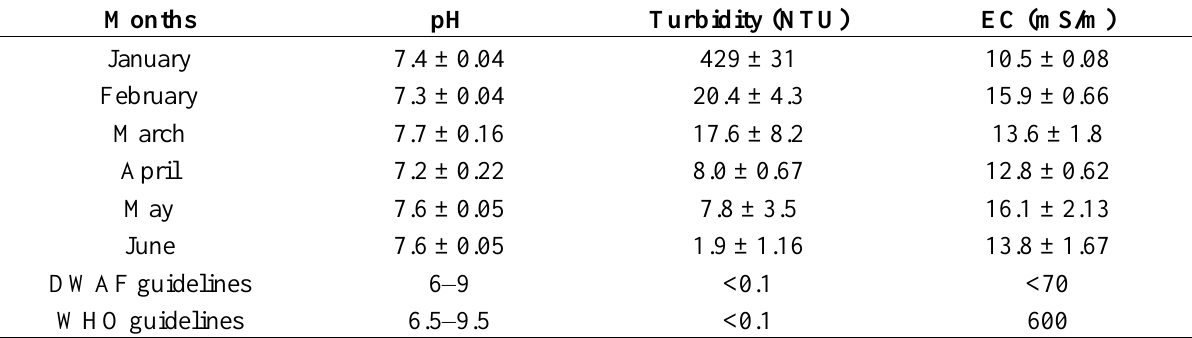
Table 1. Average levels of physico-chemical parameters in Mvudi